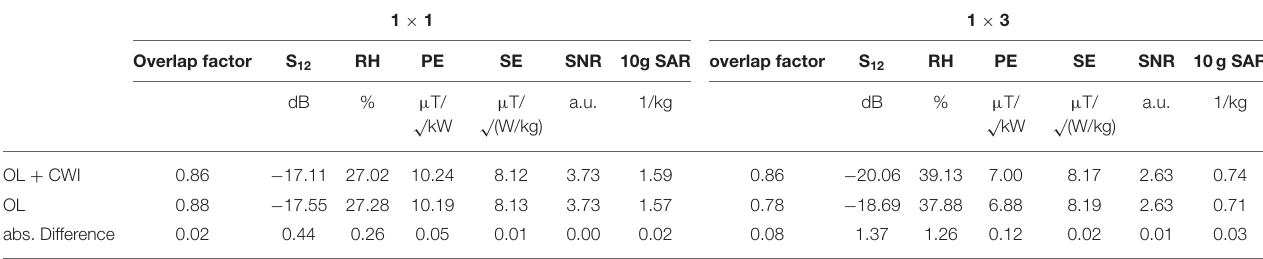
FIGURE 3 | Comparison of the 32 simulated RF coil designs. The performance parameters relative homogeneity (RH, diamonds), power efficiency (PE, squares), SAR efficiency (SE, circles), and receive efficiency (SNR, triangles) are plotted for each design. Results for Ella, Duke, and their average are depicted in purple, blue, and transparent with black rim, respectively. The figure of merit f tot is displayed as bars. The highlighted bar indicates the performance parameters of the reference single loop coil. Below the chart, the table summarizes the geometric properties of each array, x- and y-size are given in multiples of 94mm, the unit size of the housing boxes of the underlying 1 H array. The best design for both Duke and Ella is the 3-element heart-centered array with 94 141 mm ² . × TABLE 2 | Investigation of CWI decoupling elements via simulation of 2 element arrays. 1 ×